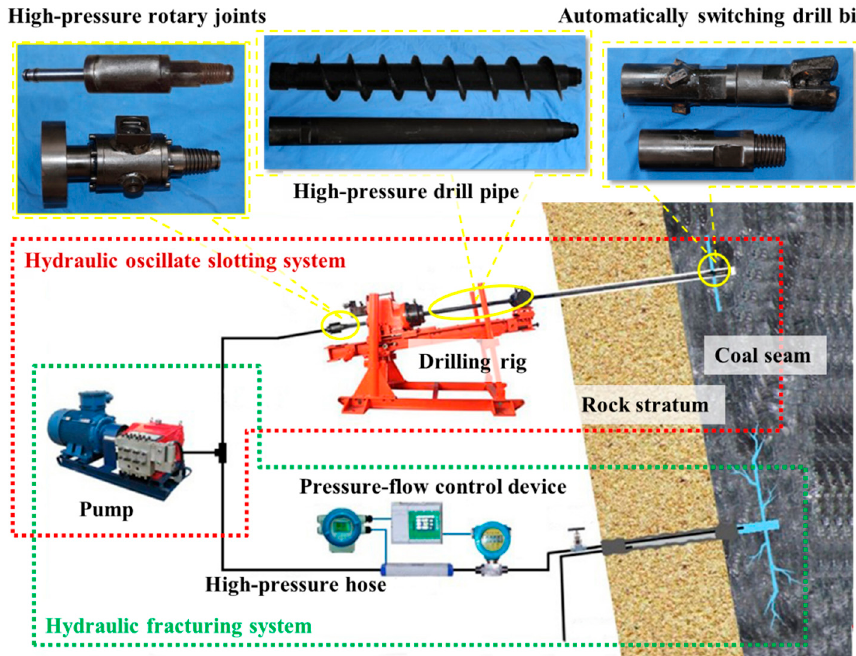
Figure 2. Systems used in the novel hydraulic technology mode.